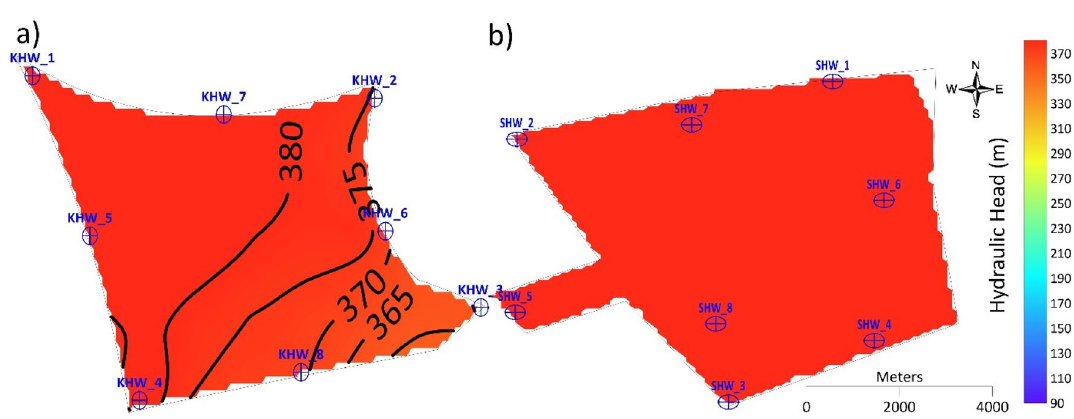
Figure 11. Simulated hydraulic head in 2030 for Scenario 4 at ( a ) Al-Khrair and ( b ) Al-Shuwaib sites. Number of